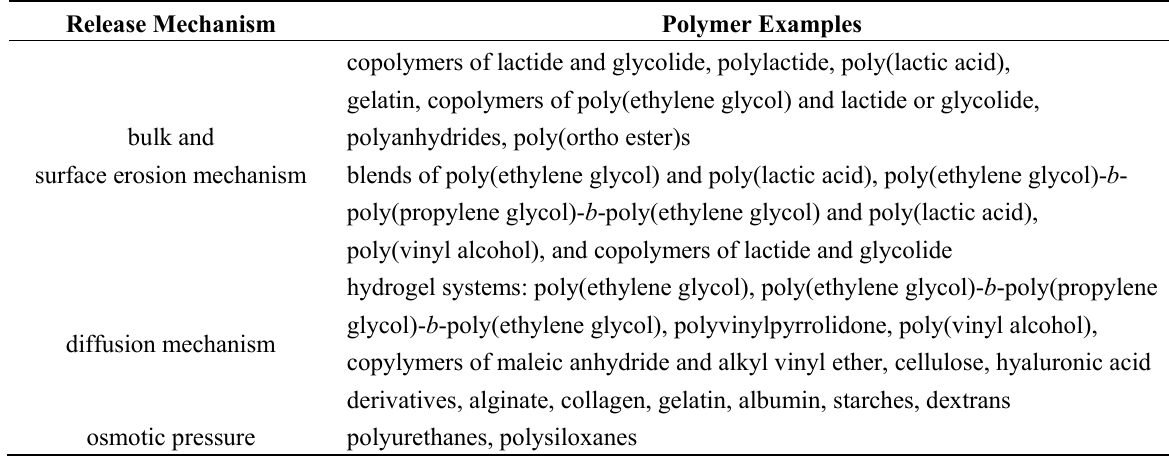
Table 1. Polymeric carriers of